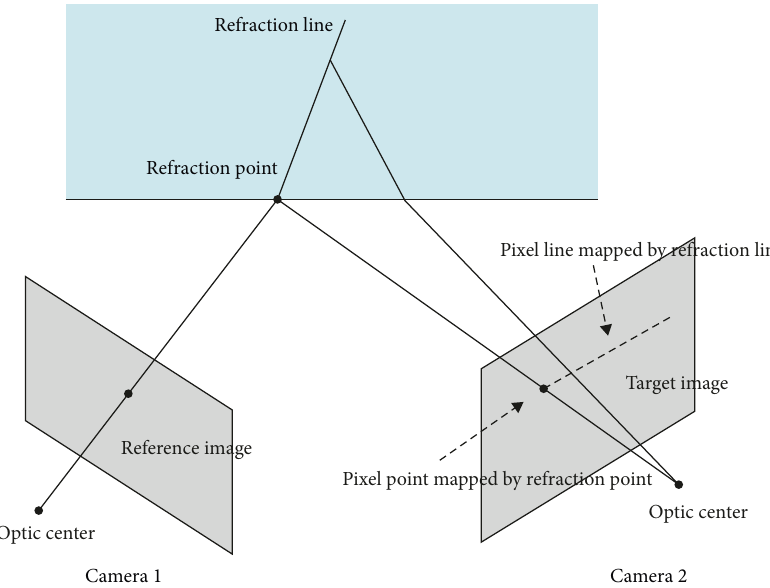
Figure 13: The alignment rectifying principle for the transparent refractive medium.